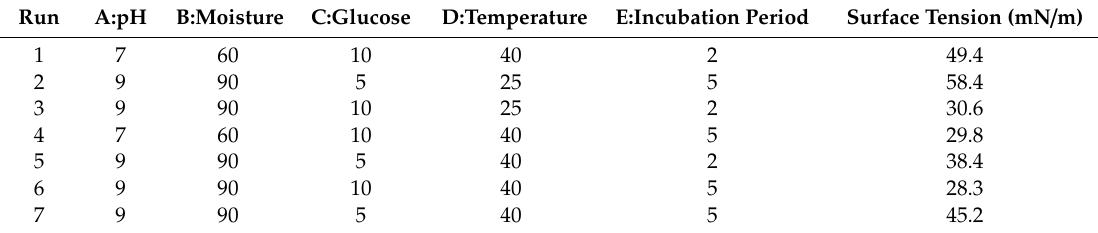
Screening of factors for the production of biosurfactant using 2 5 full factorial experimental